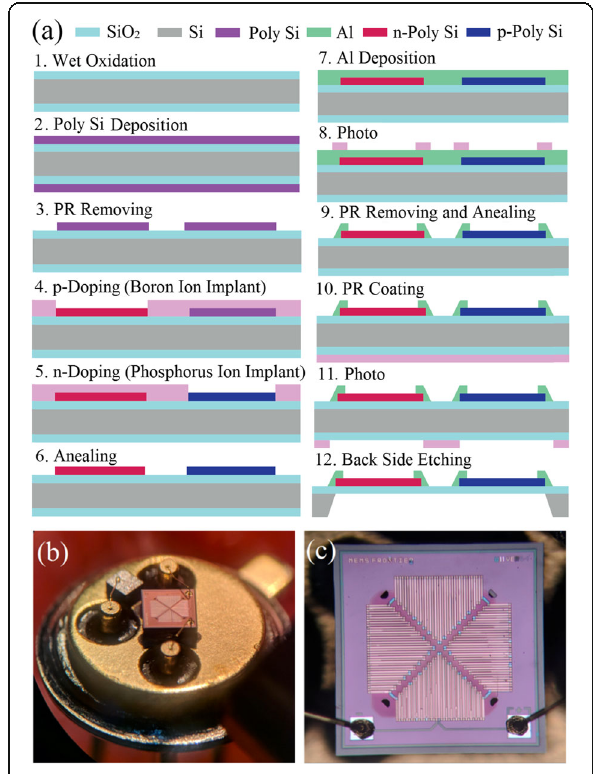
Fig. 6 a Fabrication process flow of MEMS-based thermopile detector. b Photographs of MEMS-based thermopile chip packaged in socket. c The enlarged view of thermopile